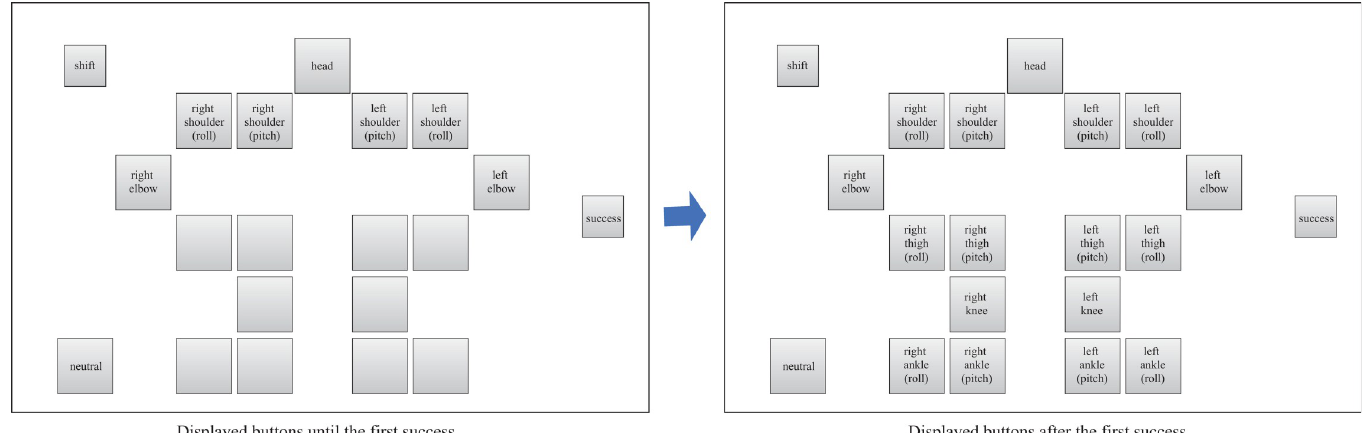
Fig 5. Command layout of the CNFS controller displayed on the tablet